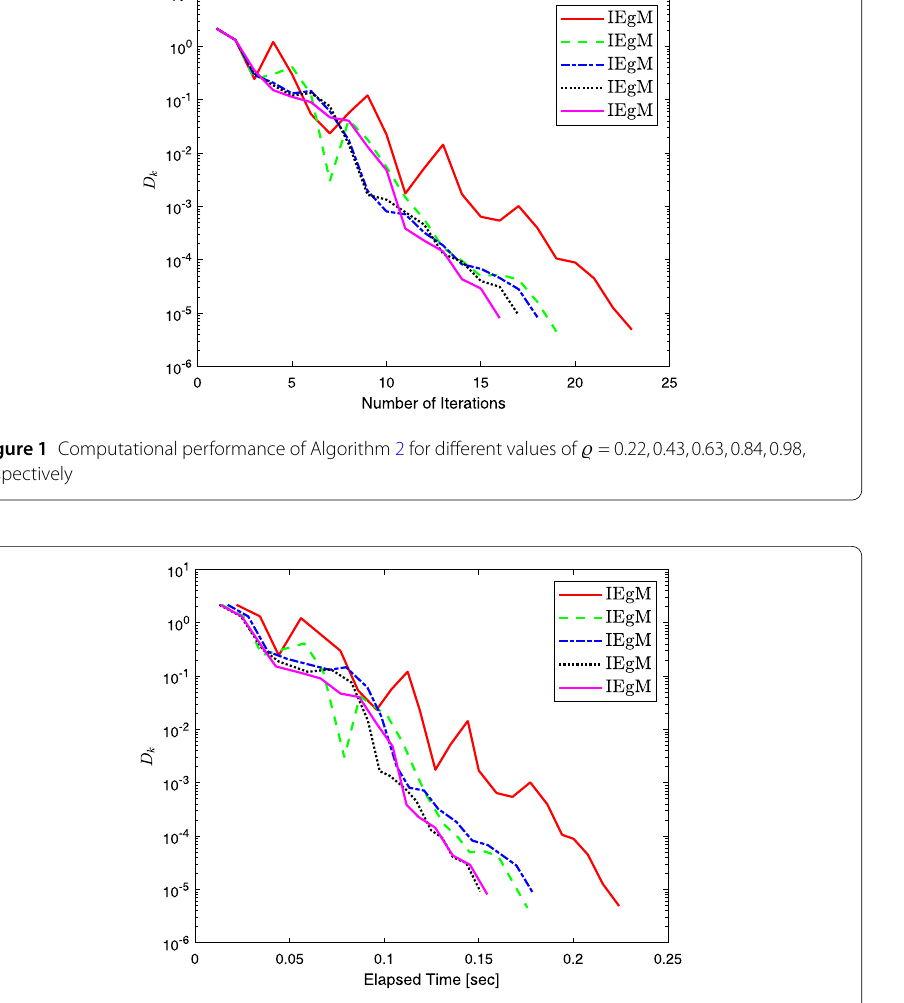
Figure 2 Computational performance of Algorithm 2 for different values of (cid:6) = 0.22,0.43,0.63,0.84,0.98,